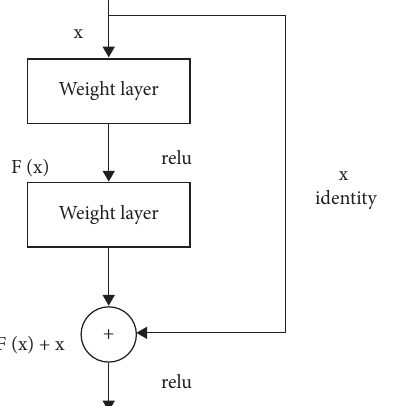
Figure 9: Building block in